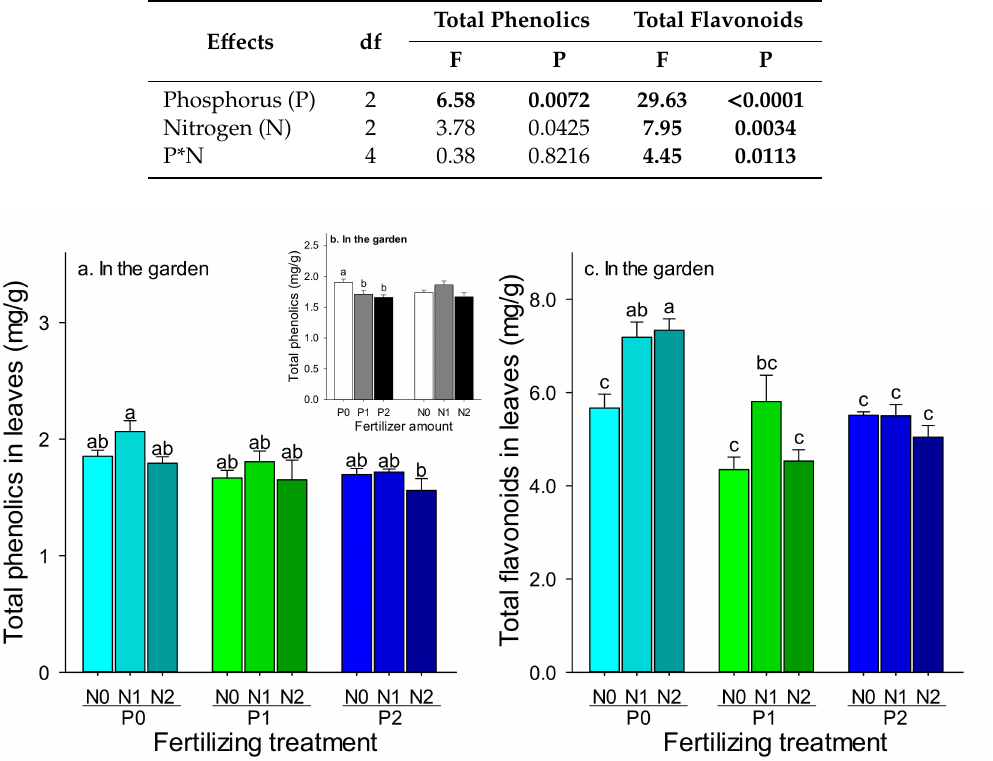
Figure 4. The e ff ect of di ff erent amounts of phosphorus and nitrogen fertilization on total phenolics ( a , b ) and total flavonoids ( c ). ( a , c ) the e ff ect of combinations of P and N Fertilization, ( b ) the e ff ect of di ff erent amount of P or N based on the two-way ANOVA. The bars are the means with SE. Bars with di ff erent letters indicate significant di ff erences based on one-way ANOVA at p <